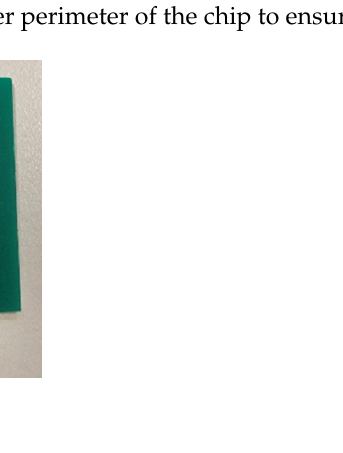
Figure 8. Simple 2D thermal model of the PowderMEMS-modified sensor. The power 𝑃 (cid:2868) that is needed to maintain a constant 𝑇 can thus be written as the sum